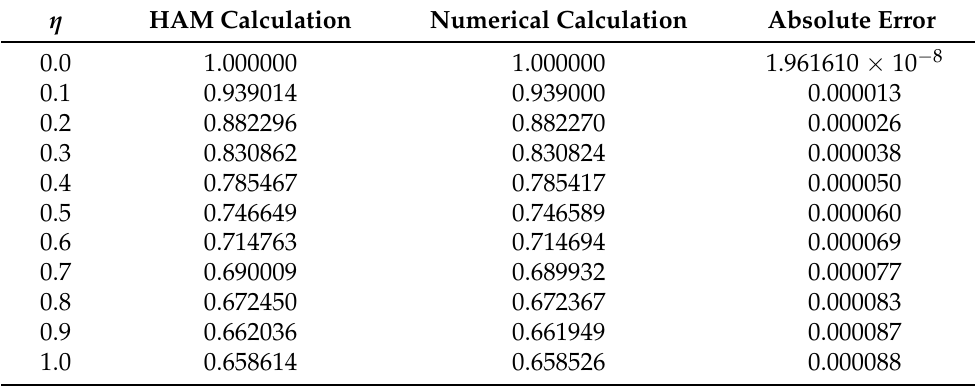
Table 3. Comparison between the analytical (HAM) and numerical results for g ( η )